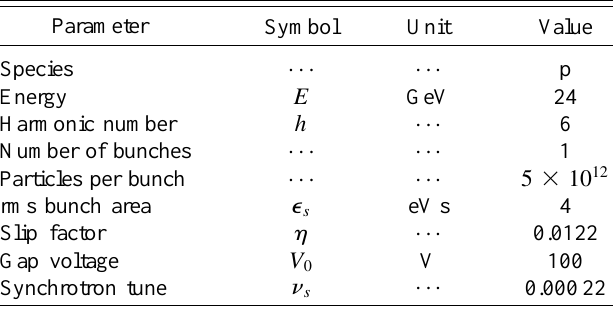
FIG. 2. Simulated particle trajectories in a surface of a section of the Hamiltonian (2) with the same parameters as given in Fig. 1. Note that the axis labels are changed to reflect the canonical phase space variables, f and d (cid:1) h h p p 2 J cos ˜ c and d (cid:1) 2 2 J sin ˜ c , that were used in Fig. 1. frame action angle variables, f (cid:1) TABLE I. Basic parameters in the AGS